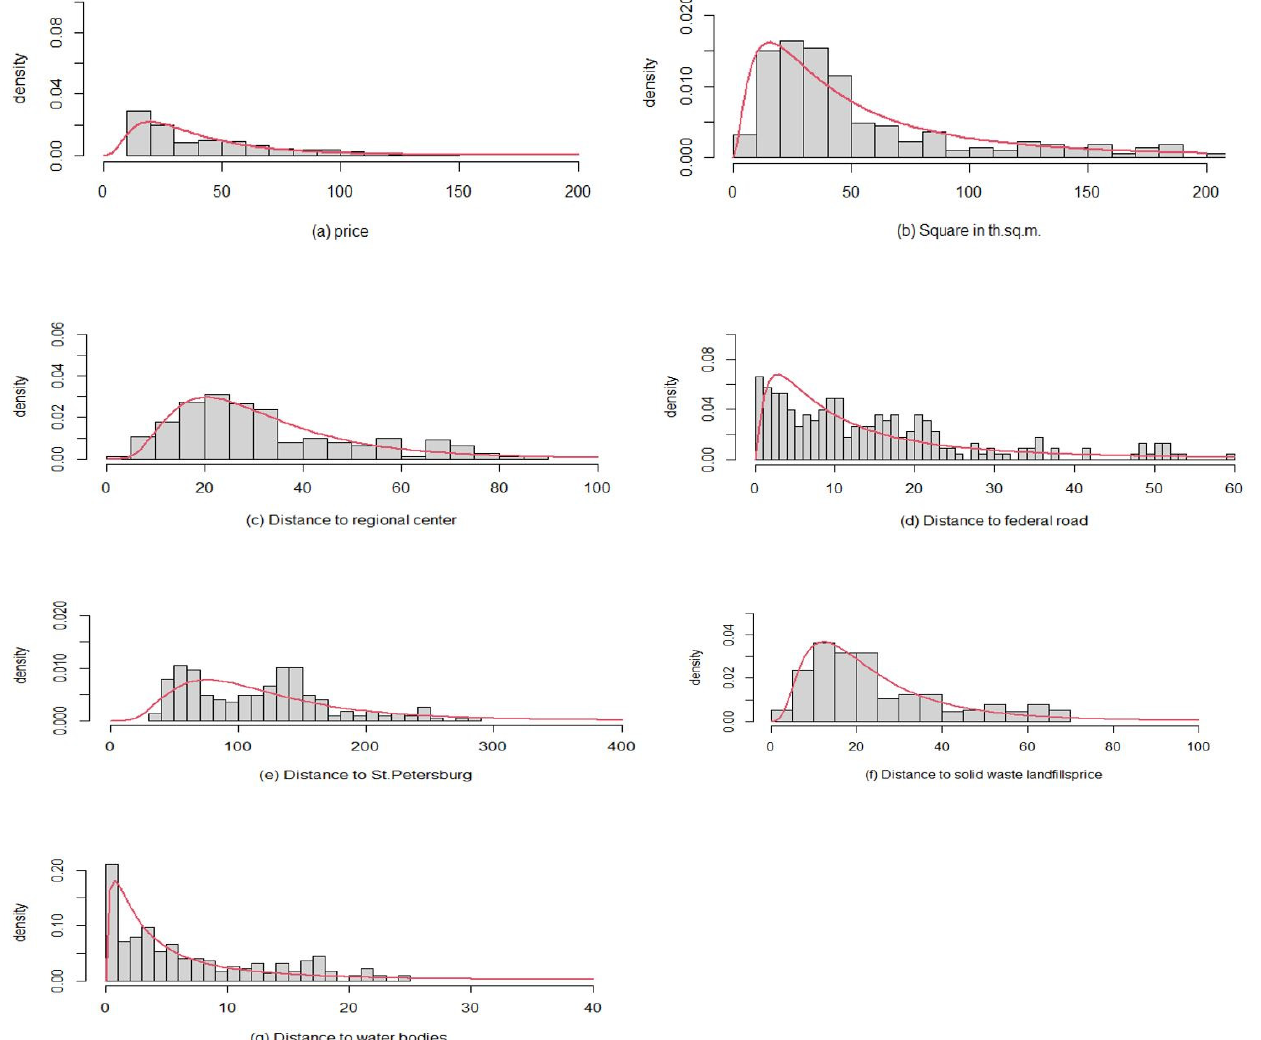
Figure 1. Empirical distributions of ( a ) price per square meter, ( b ) area, ( c ) distance to the district/regional center, ( d ) distance to federal roads, ( e ) distance to St. Petersburg, ( f ) distance to solid waste landfills, and ( g ) distance to water reservoirs.